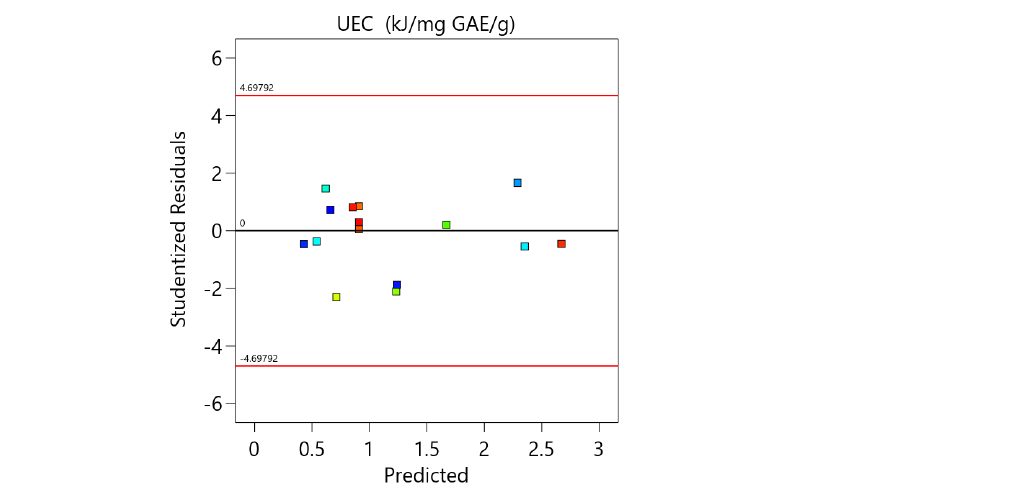
Figure A4. The comparison between the experimental and the predicted data and the residual analysis for the optimization of unit energy consumption.